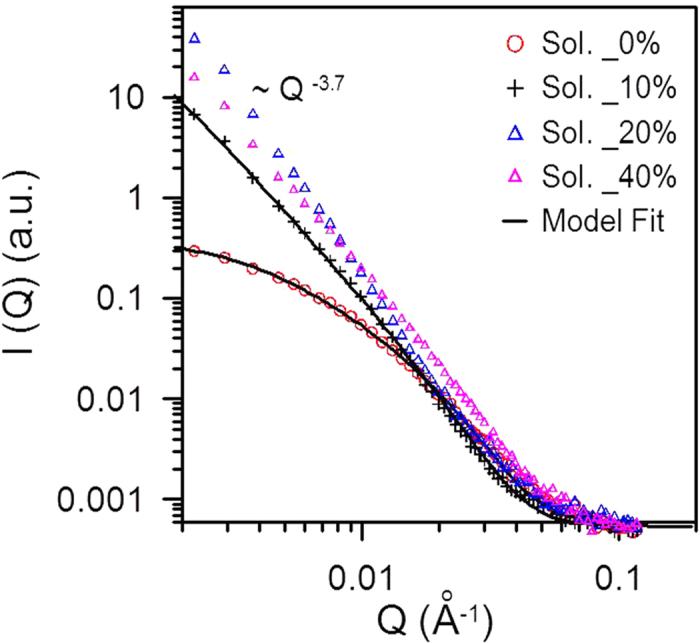
GISAXS profiles of the one-step solution-processed CH3NH3PbI3−xClx films prepared with 0, 10, 20 and 40% of chloride, respectively.